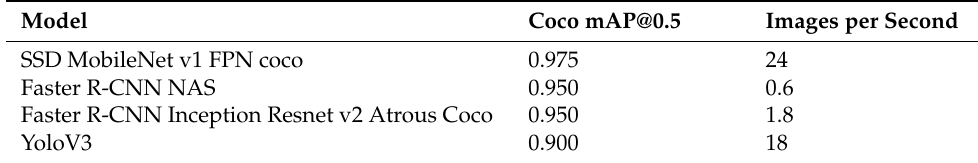
Table 1. Wing detector models with corresponding mAP and